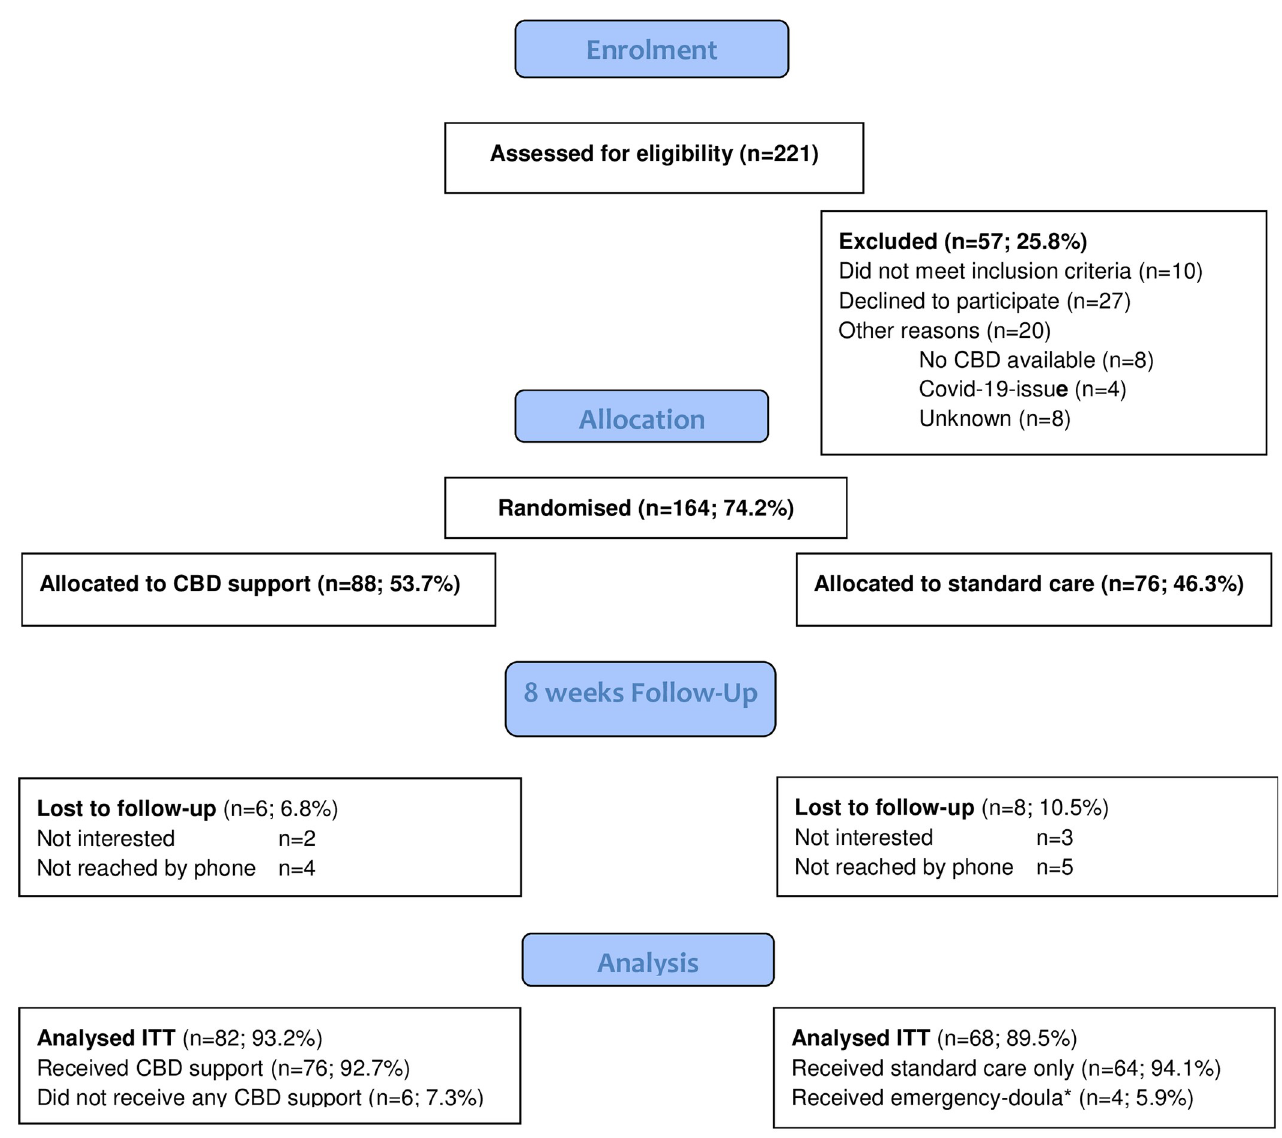
Fig 1. Flowchart of the trial enrolment, allocation, follow-up and